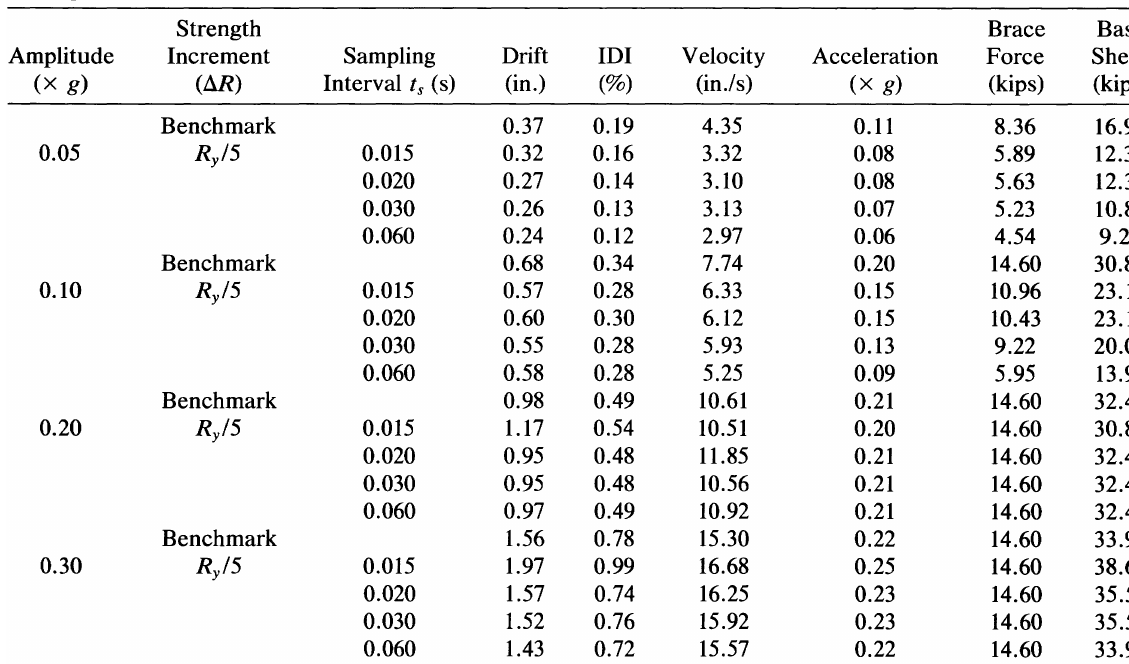
Table 1. Response Envelopes of Benchmark and ASBD Buildings Under Different Amplitude Taft Earthquakes